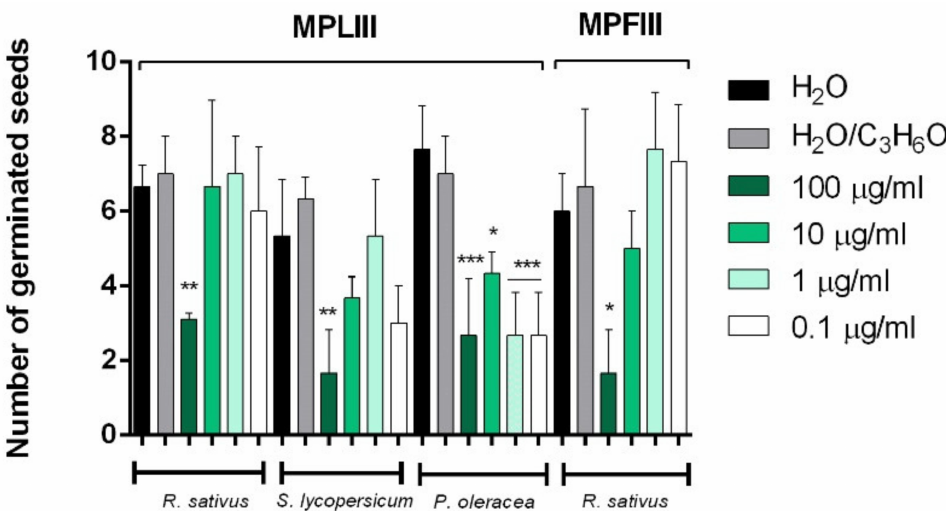
Figure 8. Phytotoxic activity of M. pulegium leaves (MPLIII) and flowers (MPFIII) EOs against germination of P. oleracea, R.sativus, and S. lycopersicum 120 h after sowing. Results are the mean of three experiments ± standard deviation. * p < 0.05, ** p < 0.01, *** p < 0.001, compared with control (ANOVA followed by Dunnett’s multiple comparison